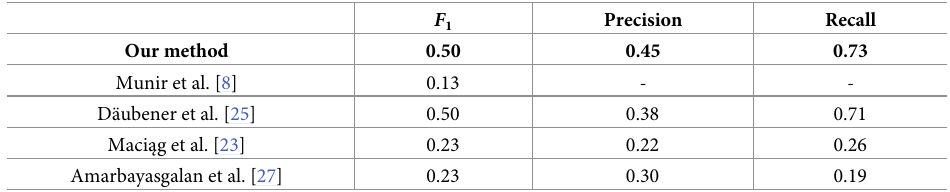
Table 2. Performance on NAB